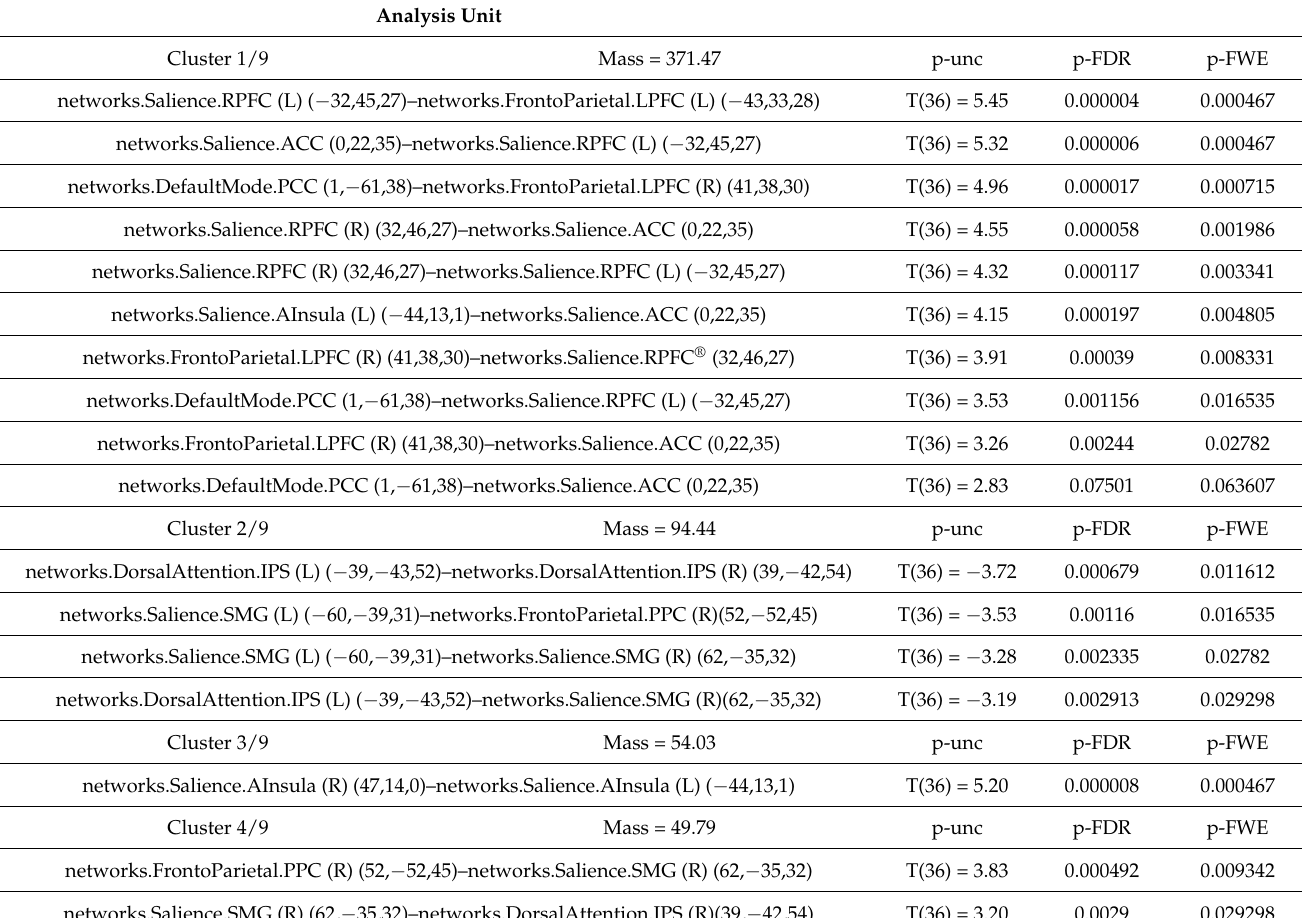
Table 1. ROI-to-ROI functional connectivity statistics of the stress